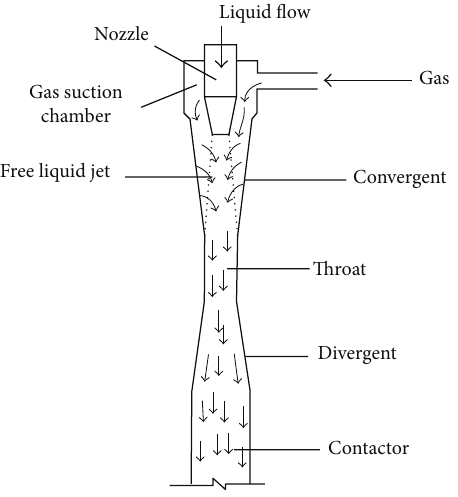
Figure 1: Typical gas-liquid jet ejector [31,